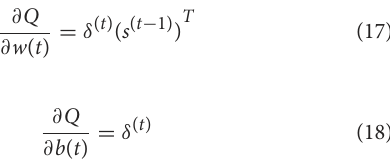
In formula (14), λ represents the learning rate, and 1 w i represents the change amount of the i-th connection